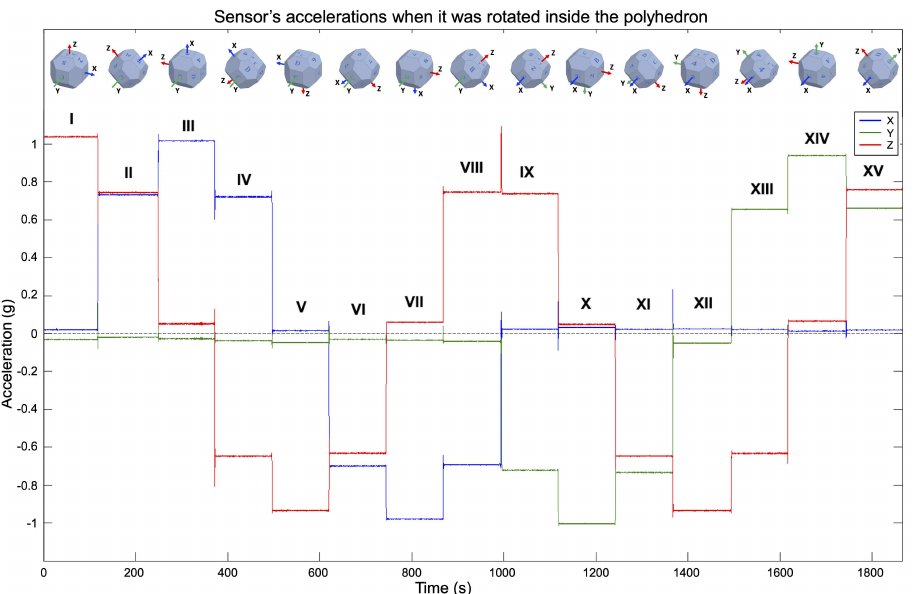
Figure 9. Measurements when the sensor was rotated with the polyhedron. The labels above the measurements are used to differentiate the orientations.